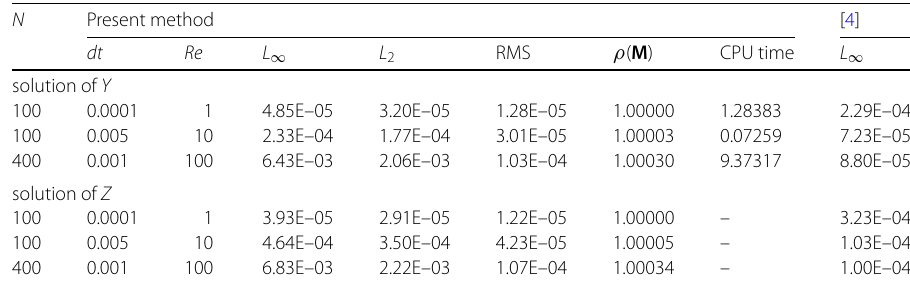
Table 13 Error norms and spectral radius for Y ( ξ , η , t ) and Z ( ξ , η , t ) of Example 7 for T = 0.01 using regular